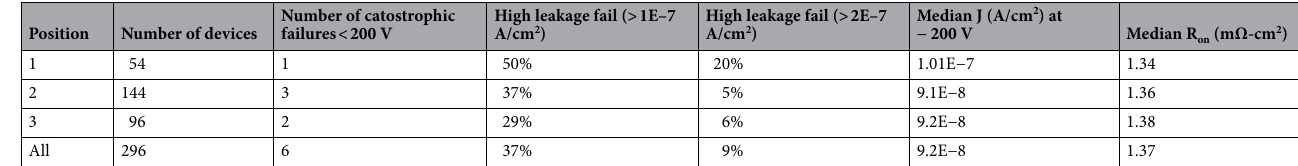
Table 1. A summary of the electrical results taken in the 3 different Raman positions defined in Fig. 3a. The data used in the analysis is shown in Figures S2 and